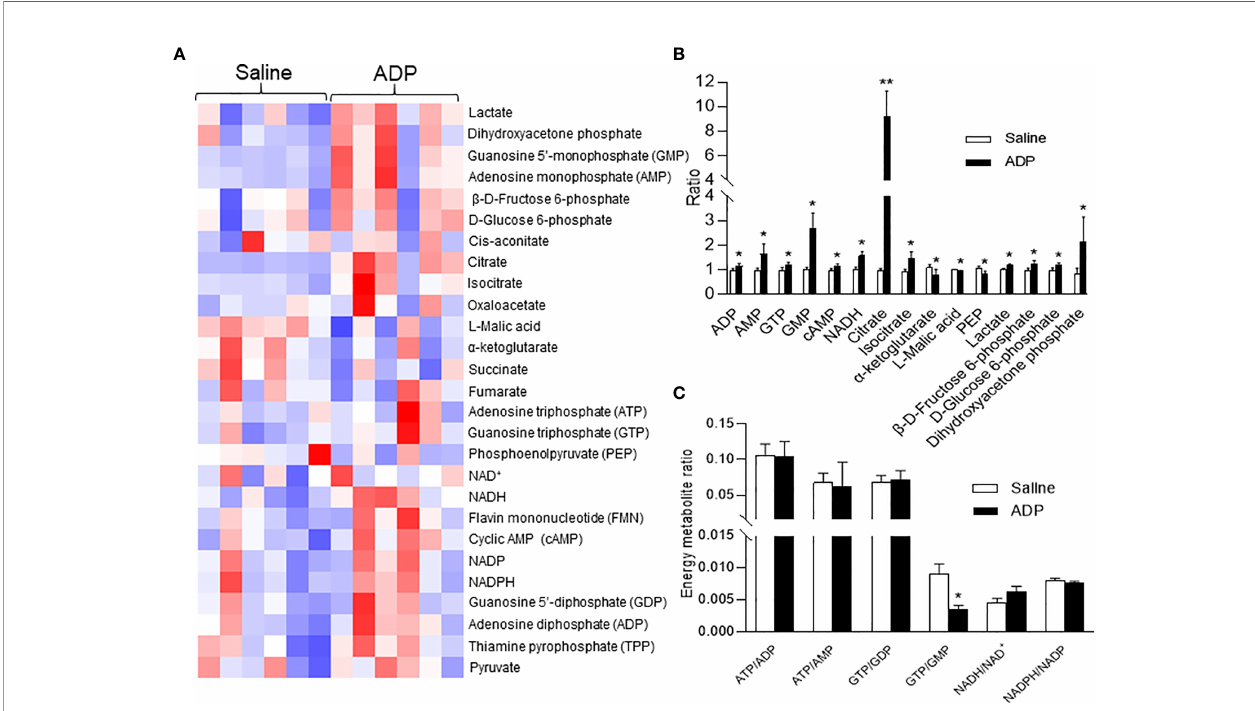
FIGURE 3 | ADP induced NADH in promotion of gluconeogenesis. Metabolite pro fi le was determined in the liver using metabolomics technology at 1h after ADP (125 mg/kg) administration. (A) Heat map of liver metabolites after ADP injection. (B) Substrate ratio. (C) Energy currency and reduction equivalent ratio. The data in the bar fi gures represent mean ± SEM (n=6). *p < 0.05; **p < 0.01 vs. the saline control